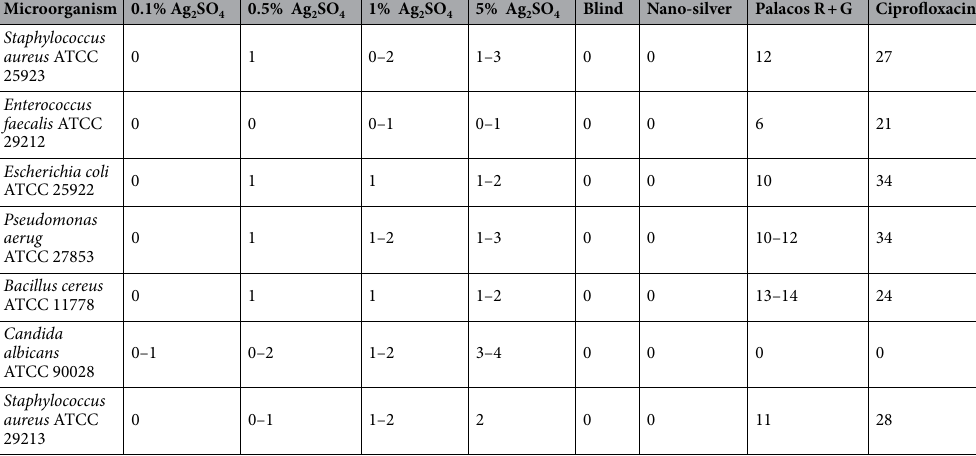
Table 1. Diameter of zone of inhibition after 24 h of incubation at 37 °C measured in